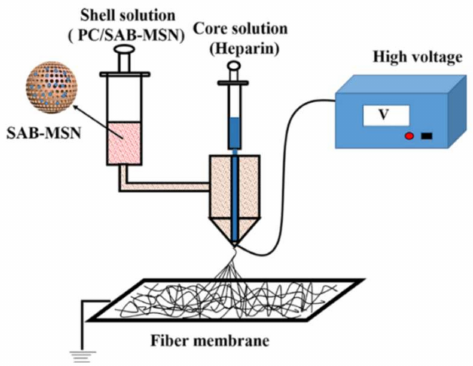
Figure3. Processoffabricatingthecore(heparin) − shell(PC / SAB-MSN)fiber. Reprintedwithpermission from [57] Copyright (2018) American Chemical